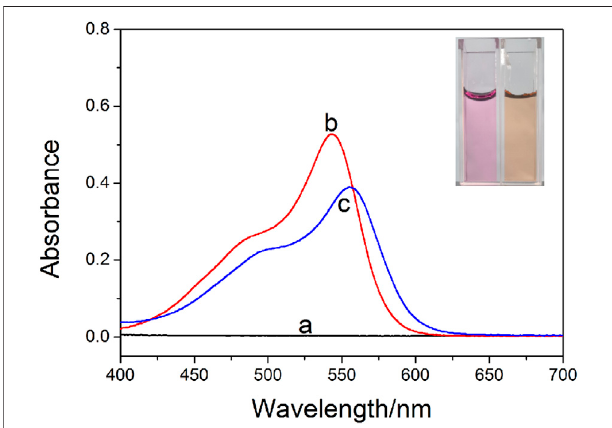
FIGURE 2 | UV-vis spectra for (A) WP6, (B) ST, and (C) ST in the presence of 50 equiv. of WP6 (1 × 10 − 3 M) in PBS (pH (cid:1) 7.2). The inserted photo displays the colour changes related to ST with the addition of